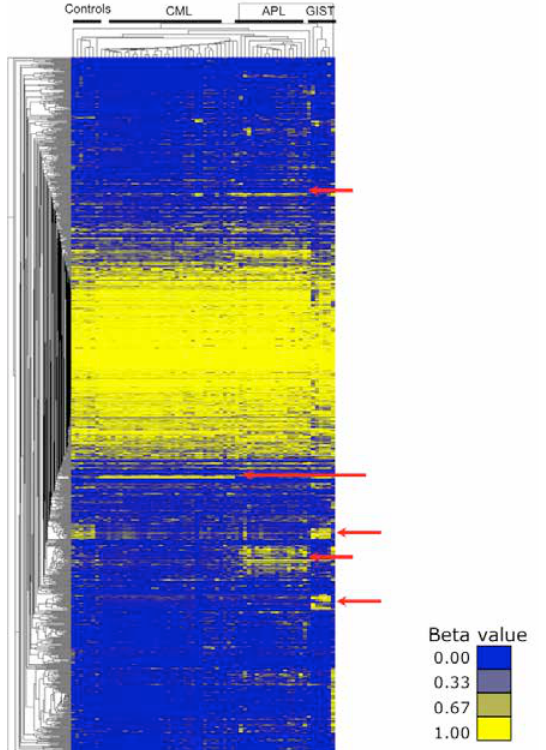
Figure 2: DNA methylation profiles of Ph + leukemias. Two-dimensio- nal unsupervised cluster analysis of DNA methylation profiles asso- ciated with the Philadelphia chromosome (CML, Ph + CD34 + , and Ph + ALL) and counterparts (Ph - CD34 + and Ph - ALL). Blue represents low DNA methylation (beta value close to 0), and yellow represents high DNA methylation levels (beta value close to 1). Different leukemia types are represented by different color bars on the top of